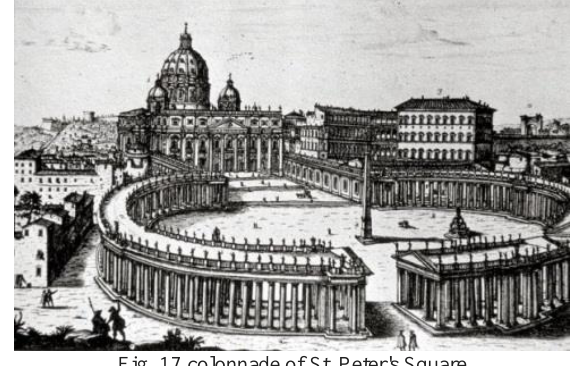
Fig. 17 colonnade of St. Peter's Square